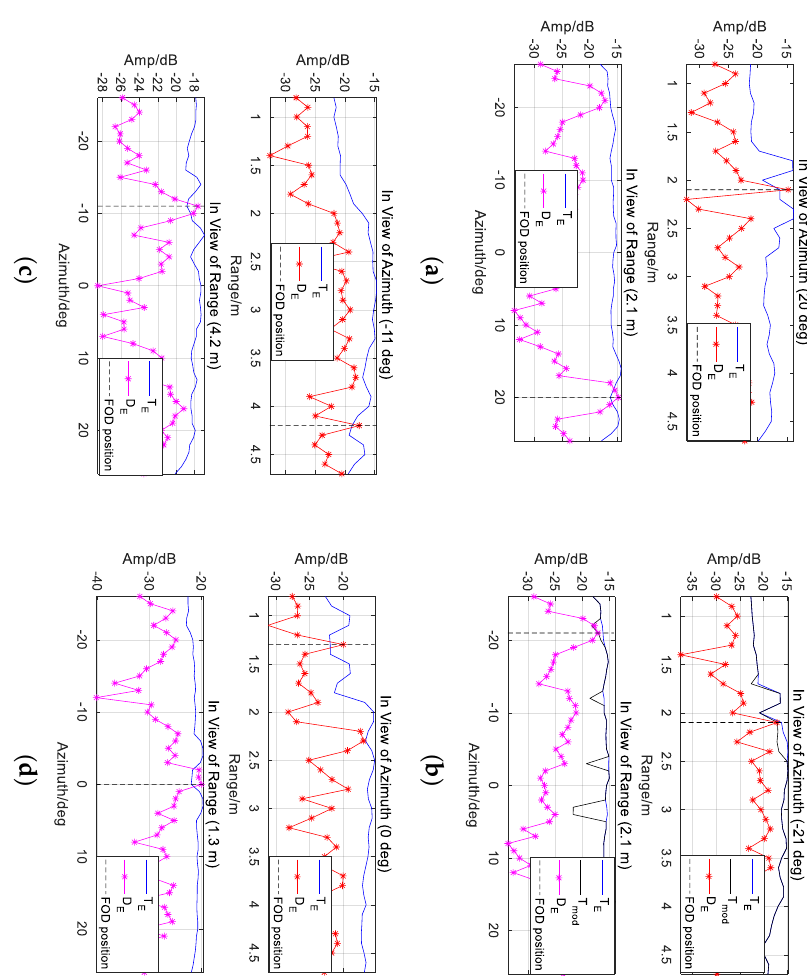
Figure 17. The results of CA-CM-CFAR detector are shown in view of range and azimuth, aiming at ( a ) Target 1; ( b ) Target 2; ( c ) Target 4; ( d ) Target 5, by employing T E or T mod